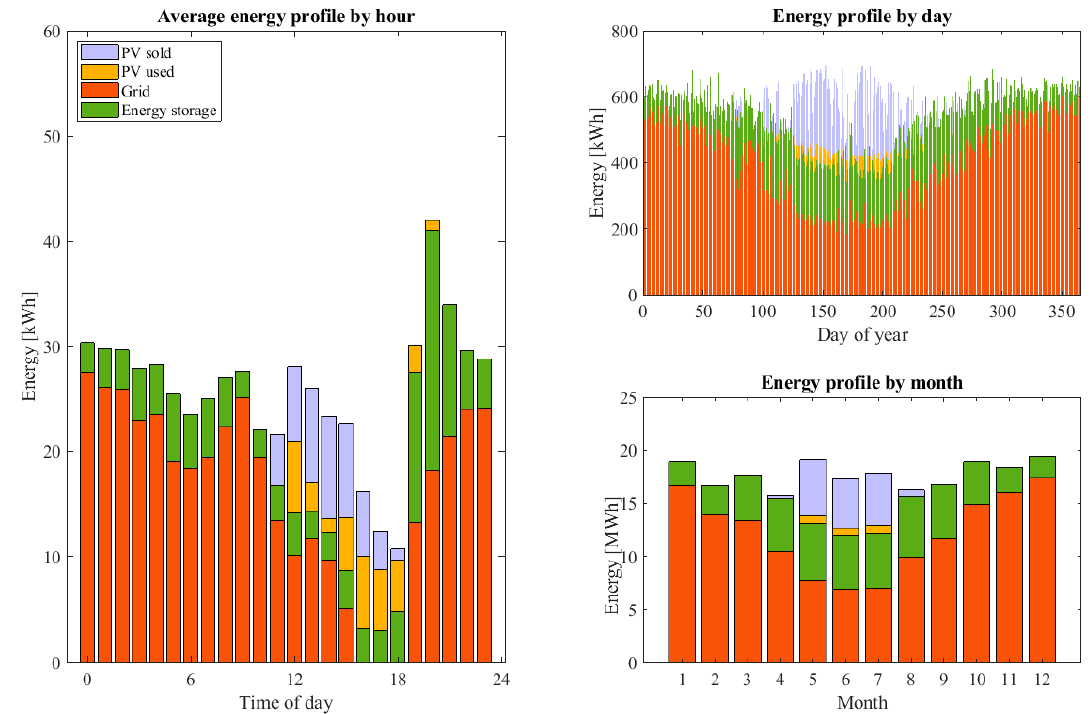
Figure 15. Average energy profiles by hour, day, and month in scenario 3.a.